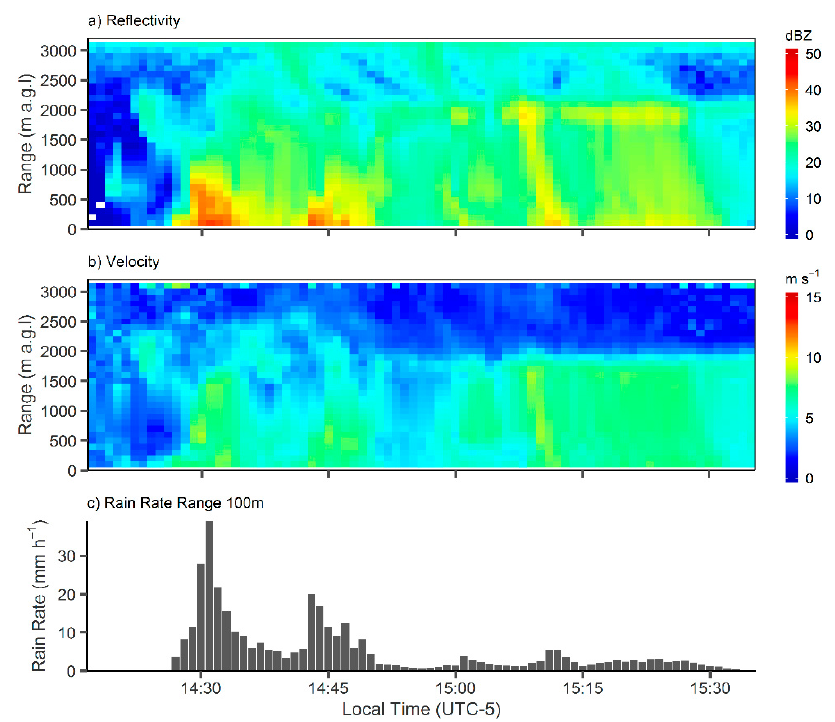
Figure 5. Event with intermittent bright band on 26 December 2017: ( a ) reflectivity profile (dBZ), ( b ) vertical fall velocity (m s − 1 ), ( c ) rain rate at range of 100 m a.g.l (mm h − 1 ). White color in ( a ), represents missing data.